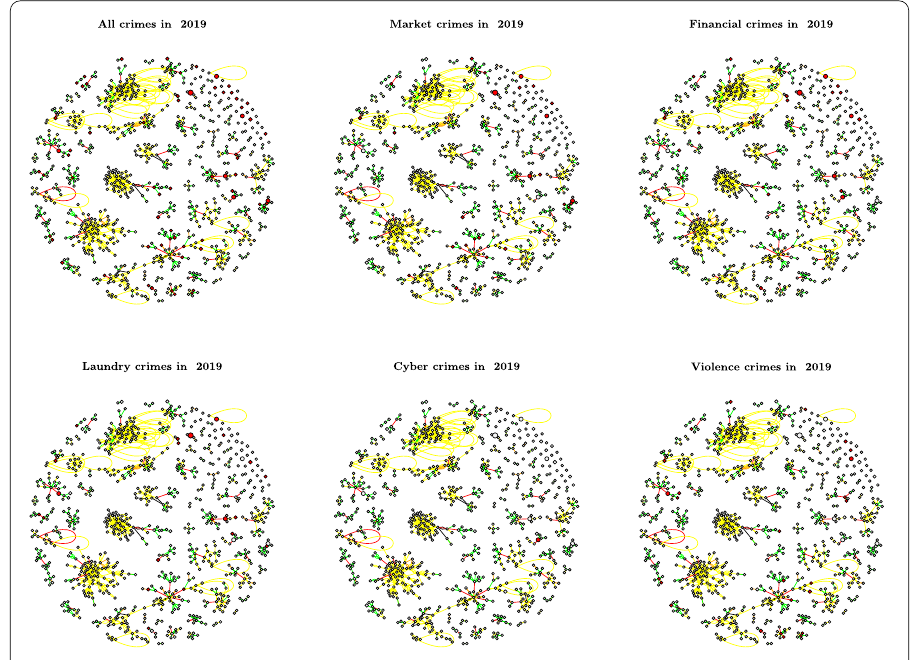
Figure 1 Example of retrieved sub-graphs with separated clusters and indicators for crime types (in sequential order): all crimes, market crimes, financial crimes, laundry crimes, cyber crimes and violence crimes. One figure that shows the retrieved network six times. Each time, nodes are colored red to indicate a different type of criminal activity (being: all crimes, market crimes, financial crimes, laundry crimes, cyber crimes